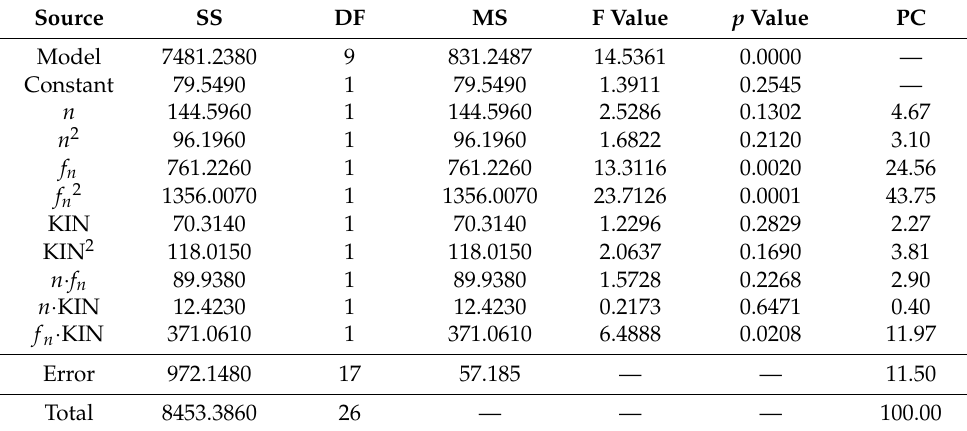
Table 8. ANOVA results for the diameter error.